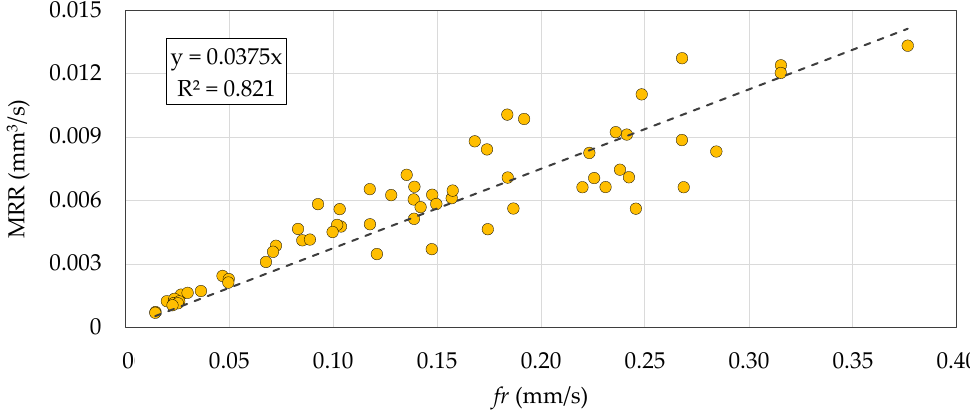
Figure 7. Correlation plot of the feed rate ( fr ) against the MRR. Each data point corresponds to one of the 64 experimental runs. The dashed line is the linear regression line.